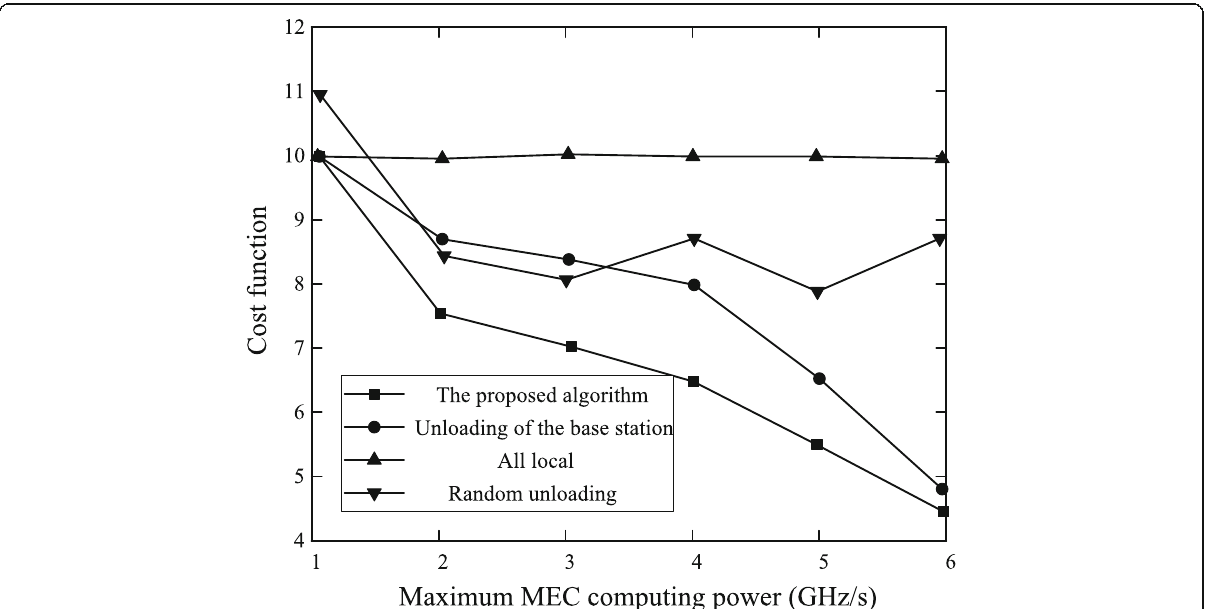
Fig. 8 Impact of MEC capacity on the performance of proposed strategy